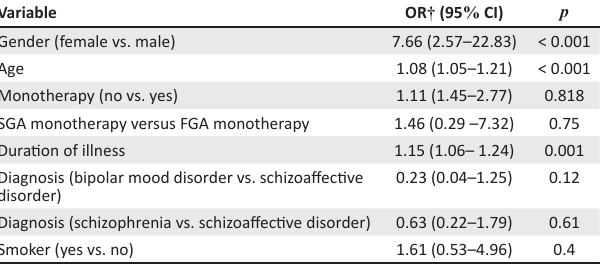
TABLE 4: Multivariate logistic regression analysis of risk factors associated with MetS in black South Africans with severe mental illness. Variable OR † (95 % CI) p Gender (female vs.